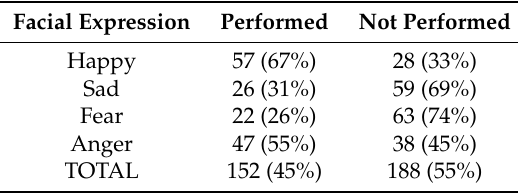
Table 7. Overview of the annotations carried out by the team of experts for ASD